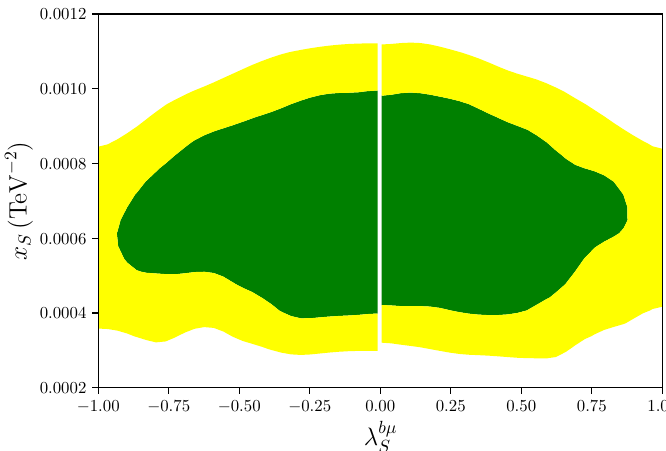
Figure 4 . The 1 (2)- σ regions in green (yellow) around the model’s best fit point. For each point in the plot, the other couplings were marginalized in order to minimize the χ 2 . The observables included in the fit were the ones available in smelli in the classes EWPO, leptonic observables, lepton flavour universality for neutral currents and quark flavour observables, and (cid:15) µµ . Values of λ bµ very close to zero were not plotted because that would imply λ sµ S and M S 3